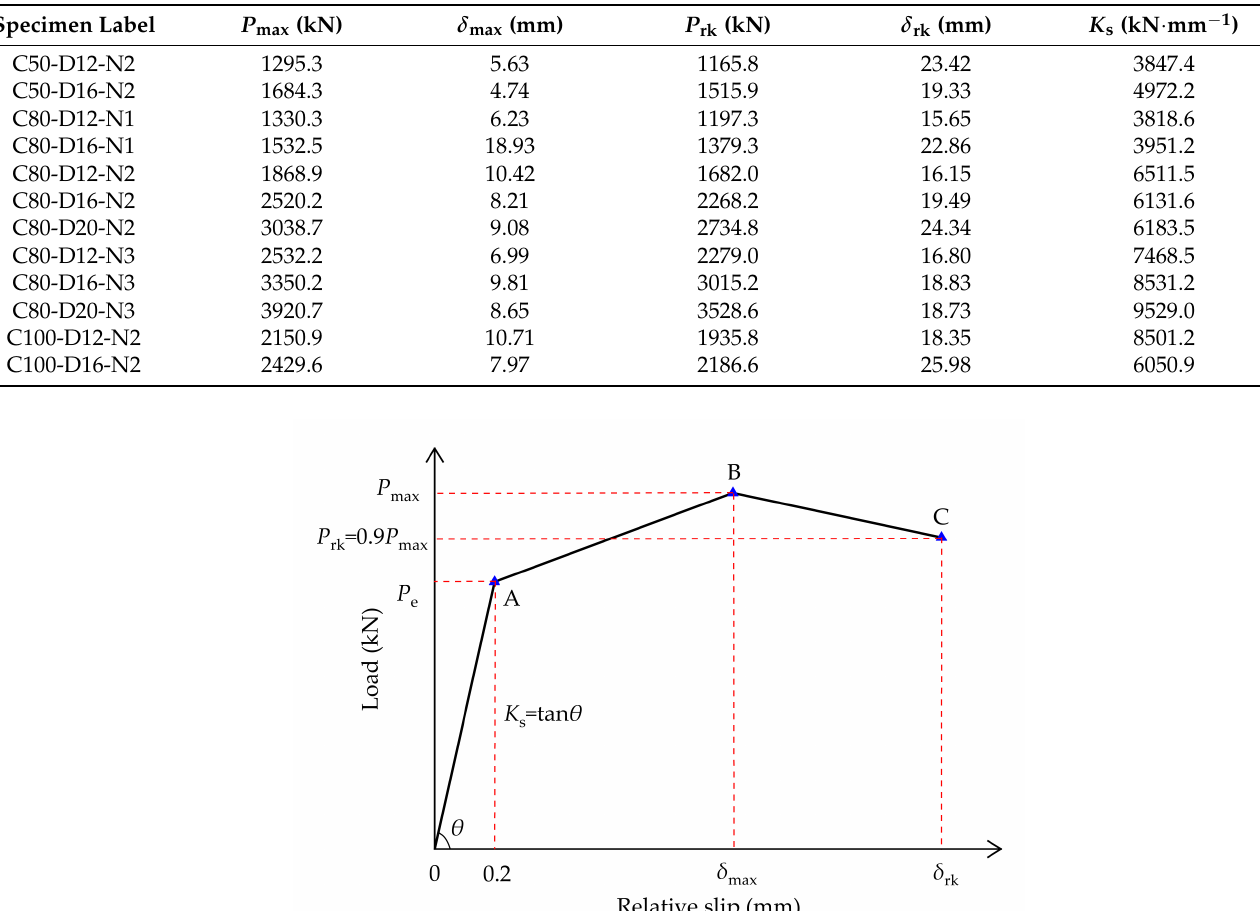
Table 2. Test results of all specimens.